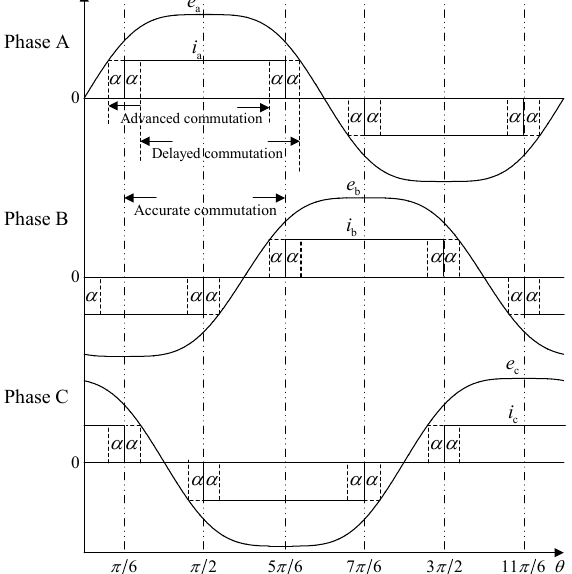
Figure 2. Phase diagram of the back electromotive forces (EMFs) and phase current.